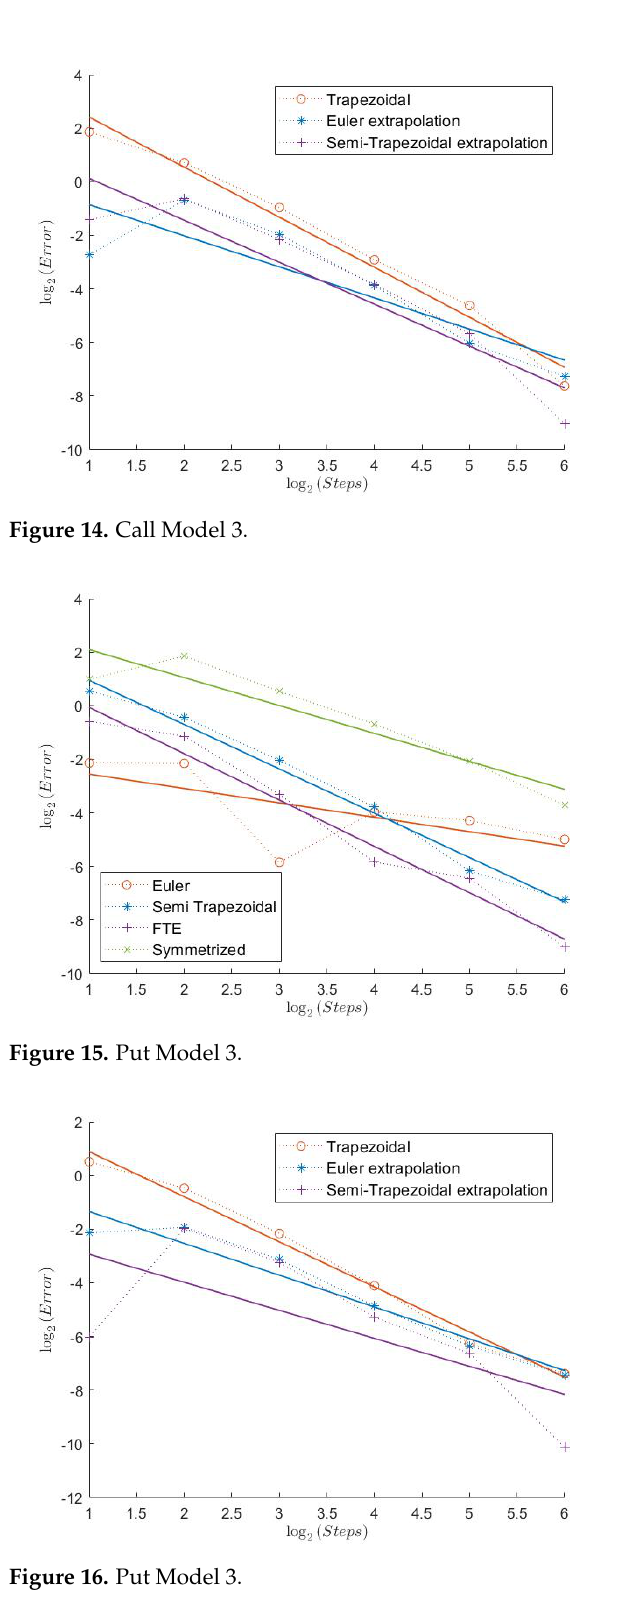
Figure 16. Put Model